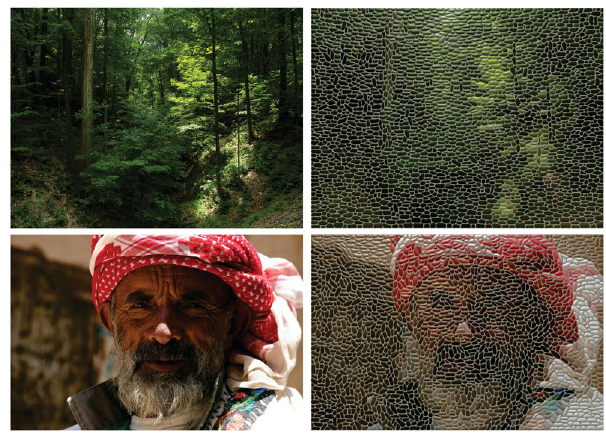
Fig. 18 Limitations of our method. Top: high-frequency features. Bottom: semantic content.